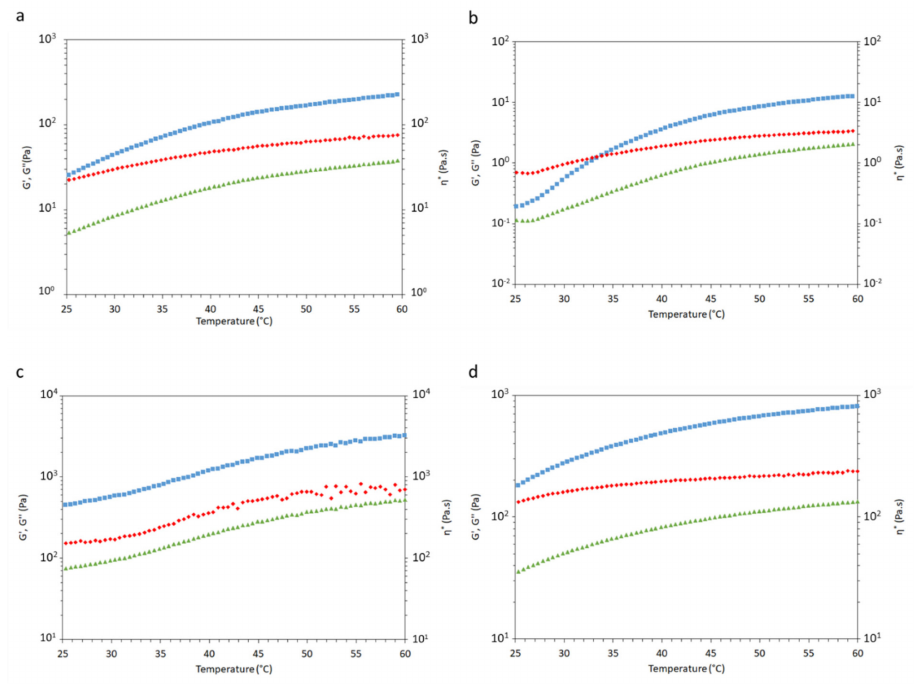
Figure 6. Rheological profile of ( a ) HA 38 - g (T3P) -M2005-8.3% at 11 wt% in water ( b ) HA 38 - g (T3P) - M2005-8.3% at 3 wt% in water ( c ) HA 140 - g (T3P) -M2005-8.3% at 6 wt% in water and ( d ) HA 140 - g (T3P) -M2005-5.5% at 6 wt% in water. Heating ramp: G (cid:48) (square), G (cid:48)(cid:48) (rhombus), η * (triangle) vs. temperature; measurement in oscillation mode (parameters shear stress: 0.02 Pa ( a , b ), 0.1 Pa ( c ) or 0.5 Pa ( d ); frequency: 1 Hz; heating rate: 0.5 ◦ C.min − 1